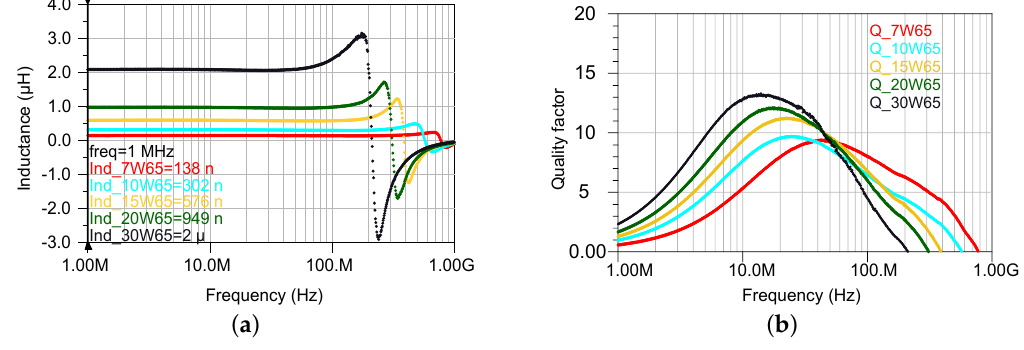
Figure 14. Frequency dependent values of the PMC core inductors for varying number of turns. The composite was made out of 65% powder. ( a ) Inductance; ( b ) Quality factor.